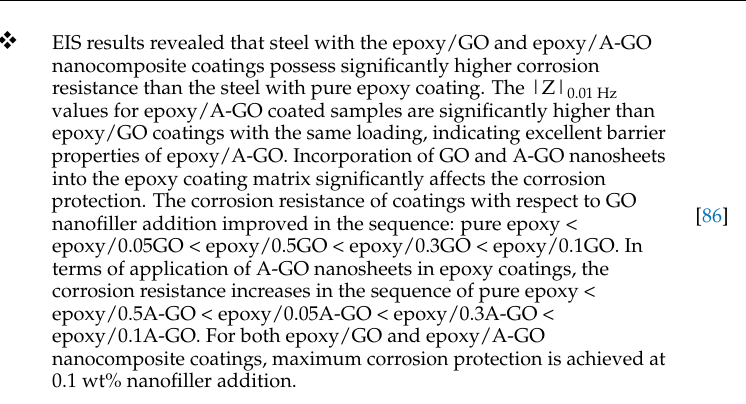
Table 1. Different approaches for improving silane coatings and the main findings, as reported in the literature. Coating Preparation Main Findings Ref.